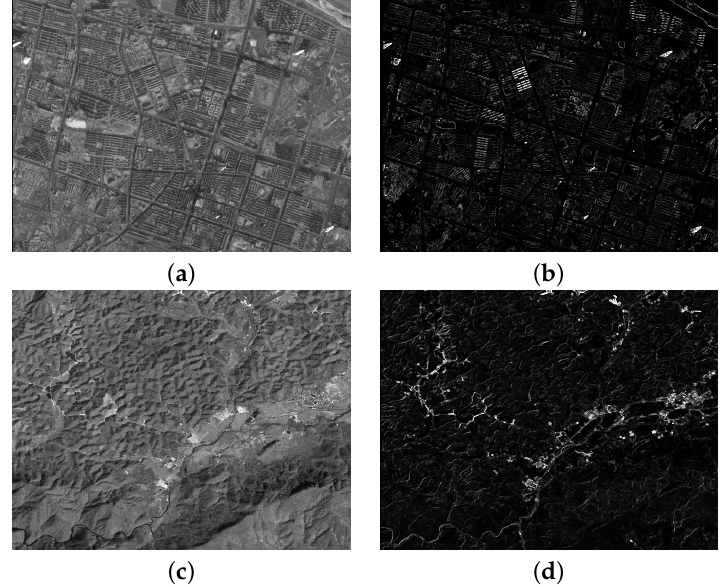
Figure 3. Examples of the distribution maps generated by the Local Contrast (LC) operator: ( a ) the satellite image of Test 1; ( b ) the distribution map of Test 1; ( c ) the satellite image of Test 2; ( d ) the distribution map of Test